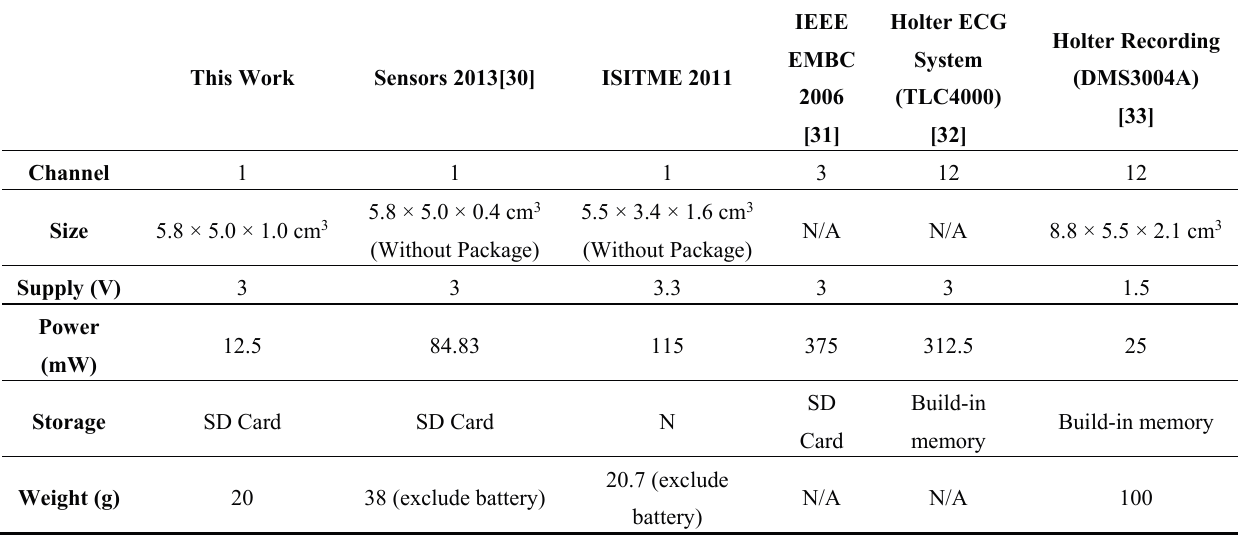
Table 3. Performance comparison between our system and other recent similar